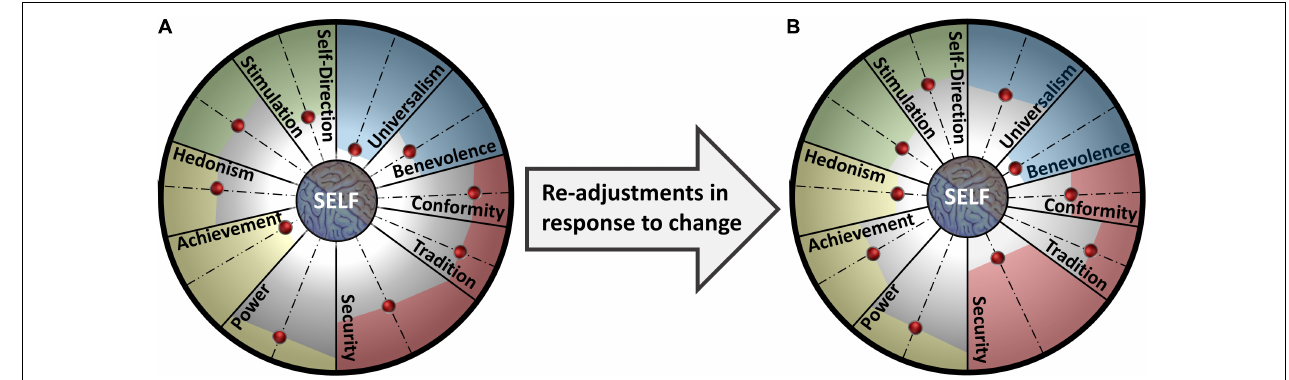
FIGURE 1 | (A) Value pattern within the value structure. (B) Value pattern fluctuation in response to